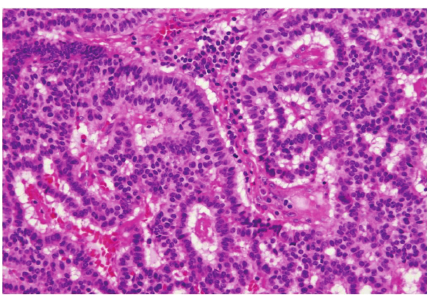
Figure 3: Microscopic findings. Tumor cells are arranged in cords and with a ribbon-like appearance (hematoxylin and eosin, magni- fication: × 400).